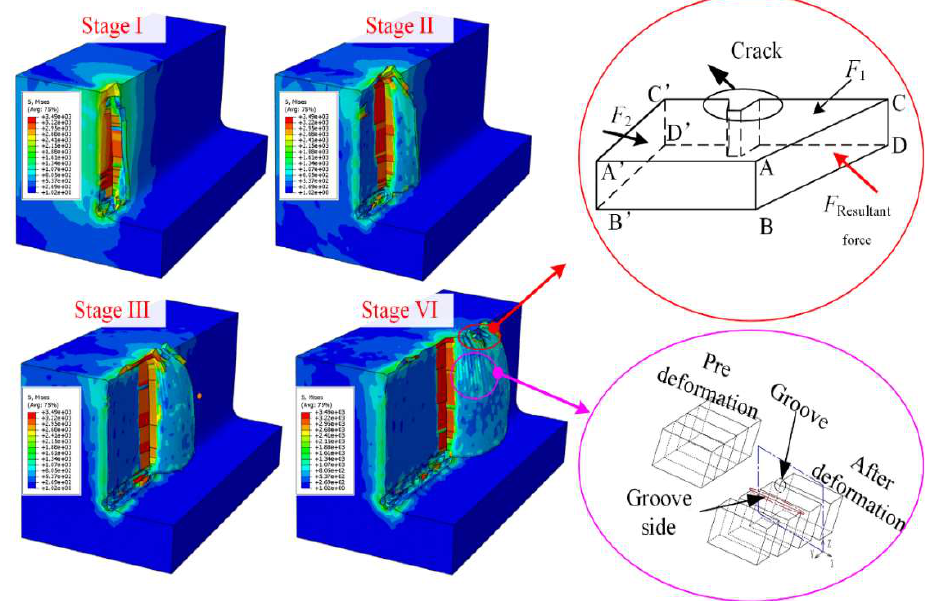
Figure 11. The chip edge crack and lamellar structure formation mechanism.